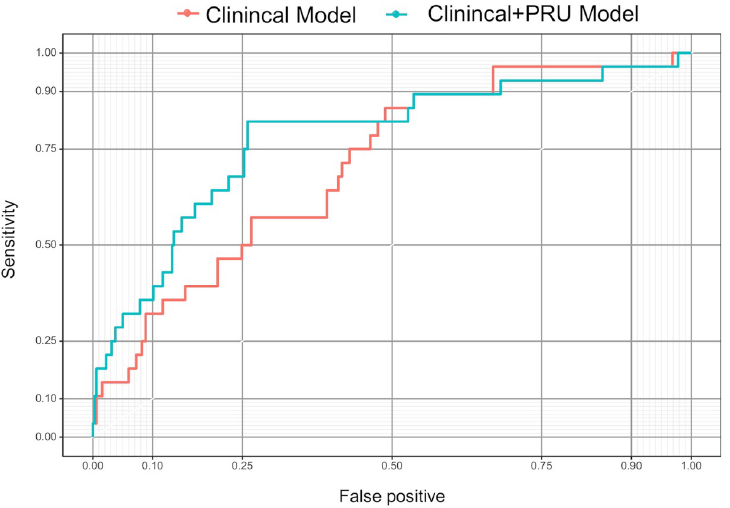
Fig 2. Receiver-operating characteristic curves for the clinical model and clinical + PRU model. Abbreviations: PRU, P2Y 12 reaction